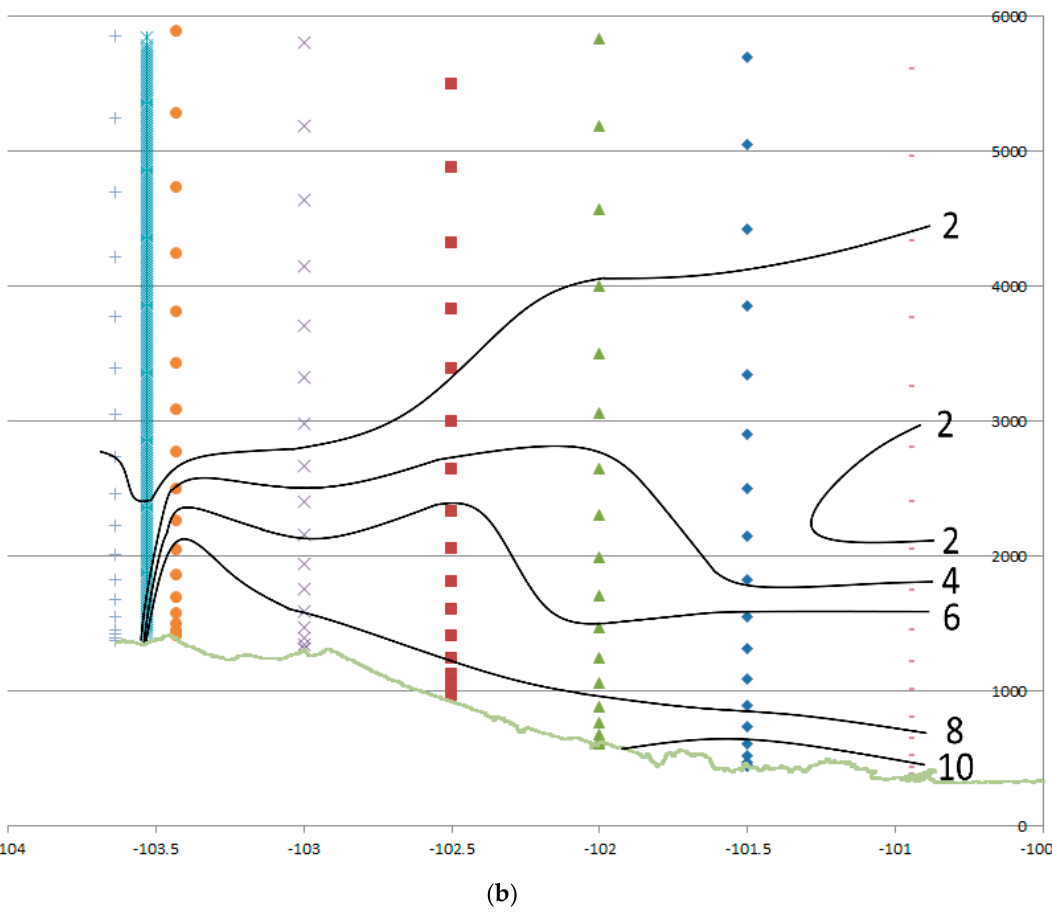
Figure 10. ( a ) Longitudinal cross-section of mixing ratio (g / kg) at 2200 UTC between Del Rio and Alpine, using Windsond (101.0 W; up to 3000 m) and HRRR profiles together with surface data. Heights are in m MSL. Markers indicate model and observational levels. ( b ) Longitudinal cross-section at 0400 UTC of mixing ratio (g / kg). Windsond data are used at 103.5 W.